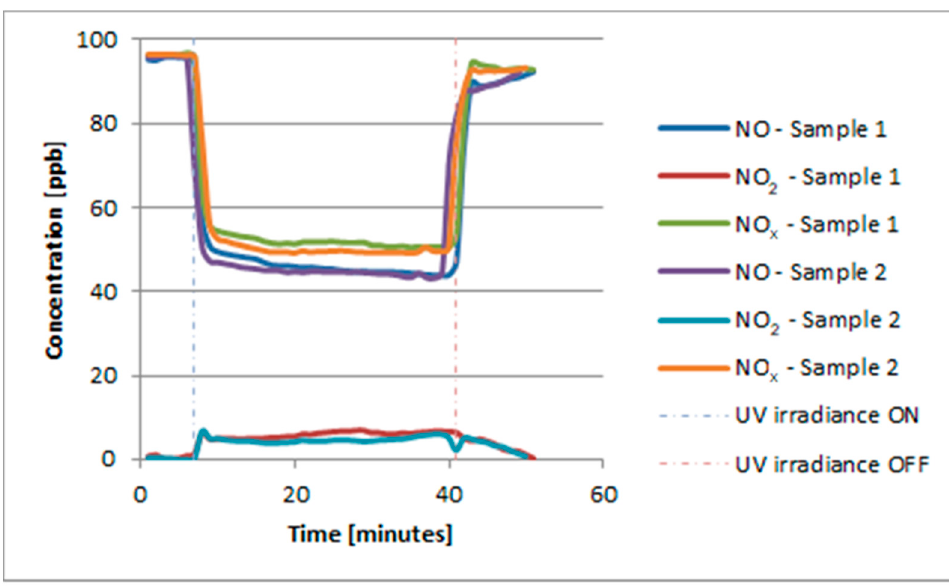
Figure 13. NO, NO 2 , and NO x abatement with artificial UV irradiance.